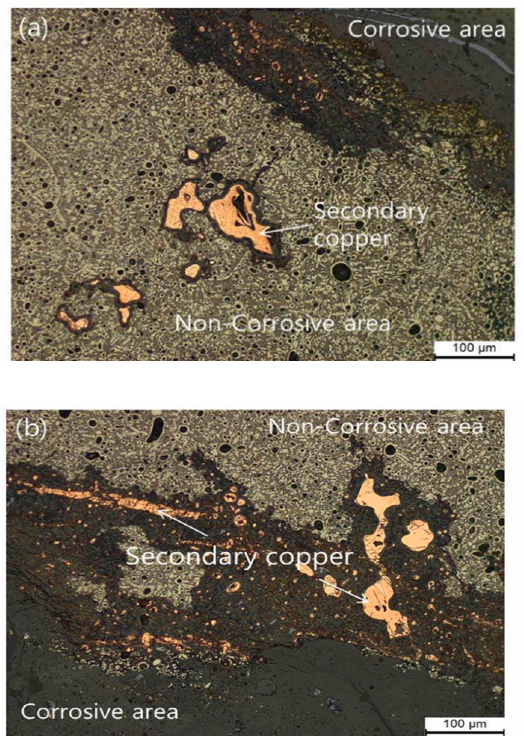
Figure 10. Ga-35 (No. 3) optical micrograph with secondary copper particles ( a ) and twinned secondary copper ( b ).